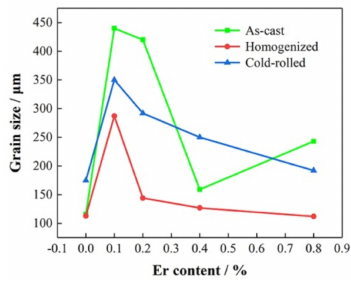
Figure 7. Relation between grain size and Er content of 5052 aluminum alloys.